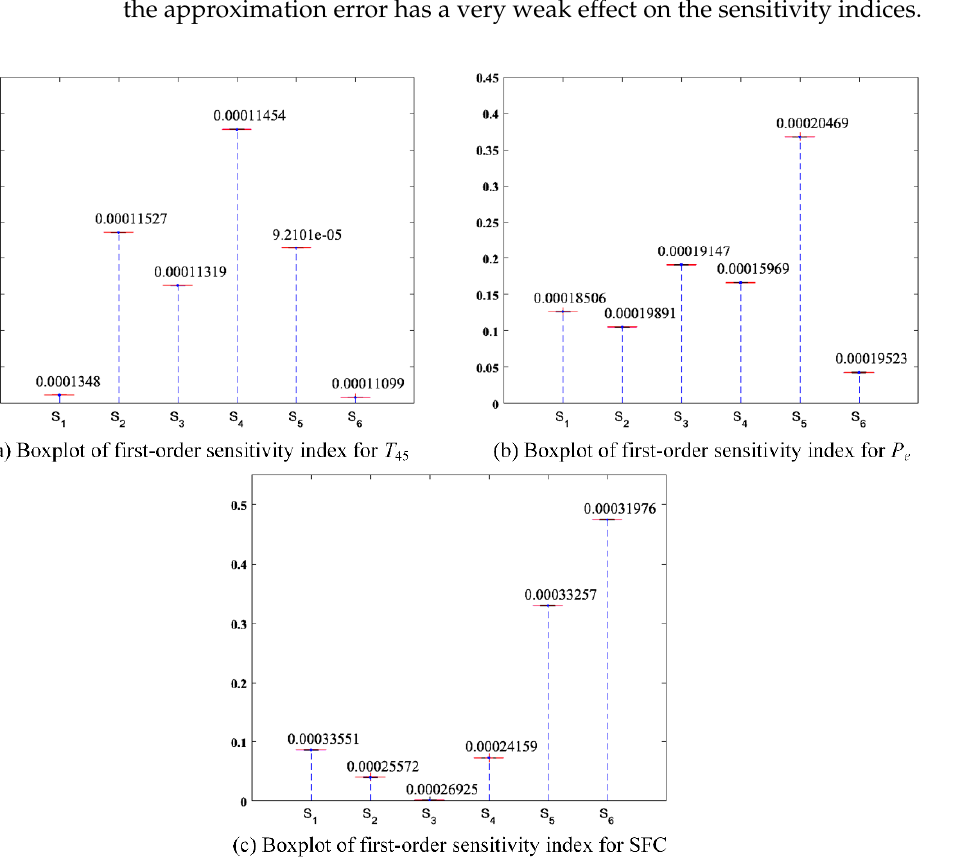
T ; ( b ) the boxplot of first-order sensitivity index for 45